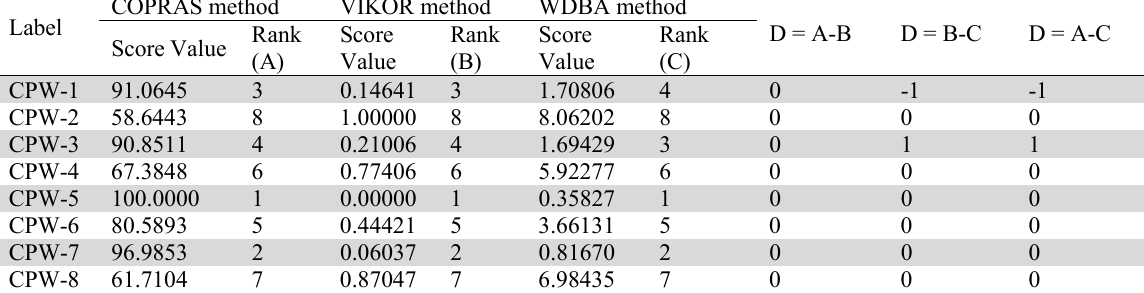
Ranking results with their differences of COPRAS, VIKOR and WDBA